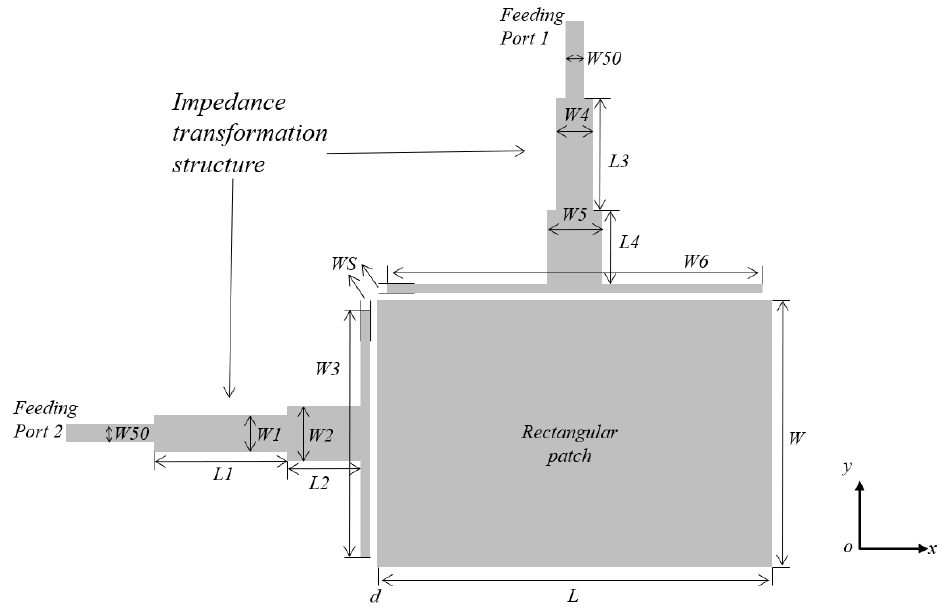
Figure 1. Geometry of the proposed direction-sensitive microwave sensor.